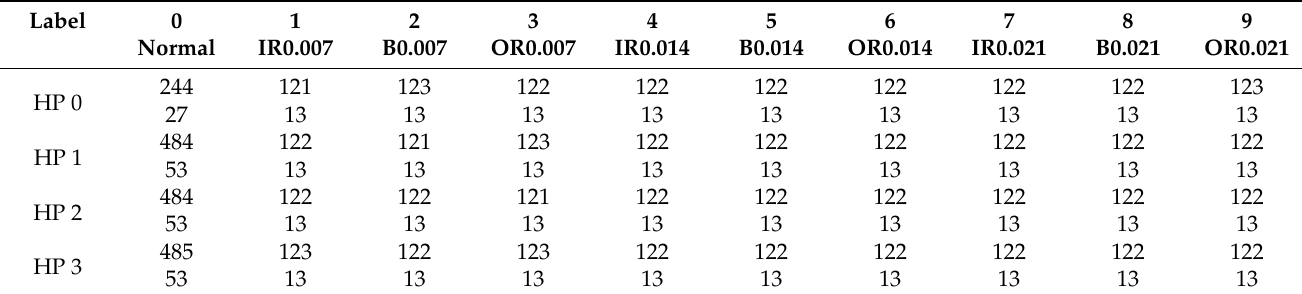
Table 4. CWRU dataset of four load conditions.